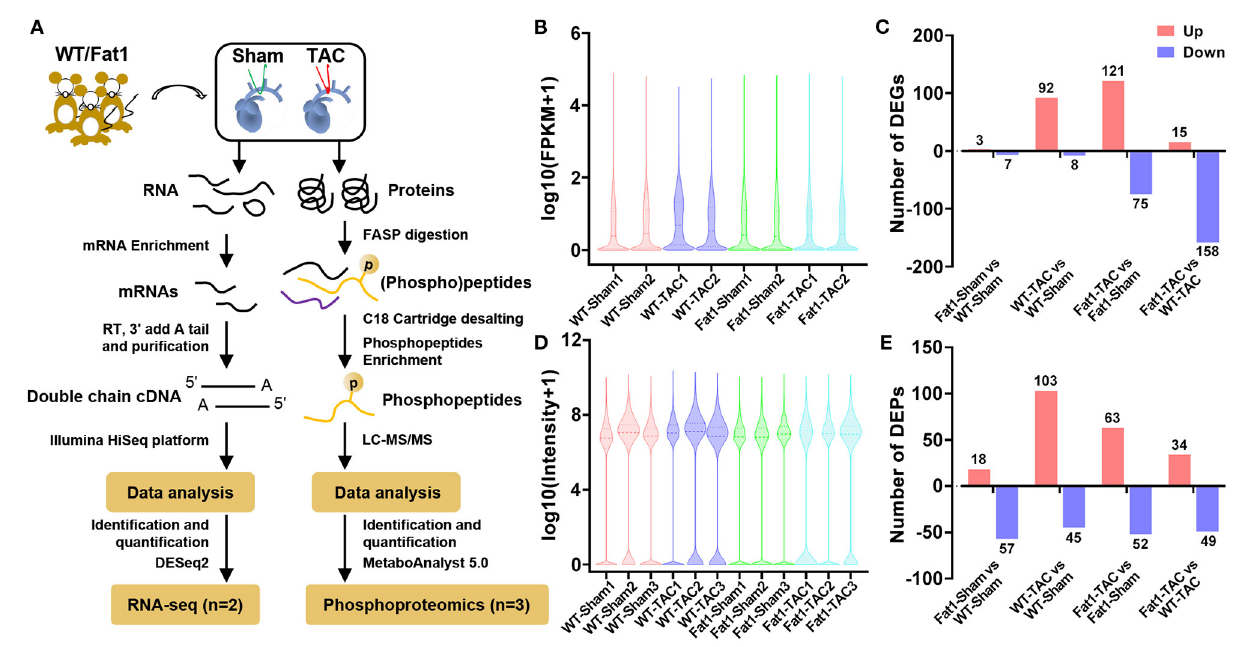
FIGURE 2 | mRNA and phosphoprotein profiles. RNA-sequencing analysis of (A) overall mRNA expression profiles (B) and differentially expressed genes (DEGs) in pressure overload hearts (C) . Quantitative phosphoproteomic analysis (A) showed the overall expression profiles of phosphoproteins (D) and differentially expressed phosphoproteins (DEPs) in pressure overload hearts (E) . N = 2 and 3 for RNA-sequencing and phosphoproteomic analysis,